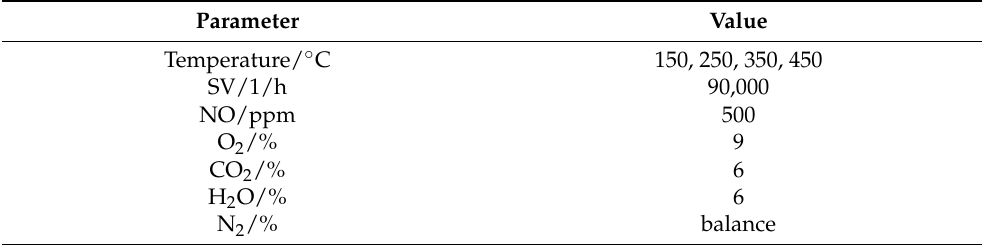
Table 3. Conditions for NO X storage capacity